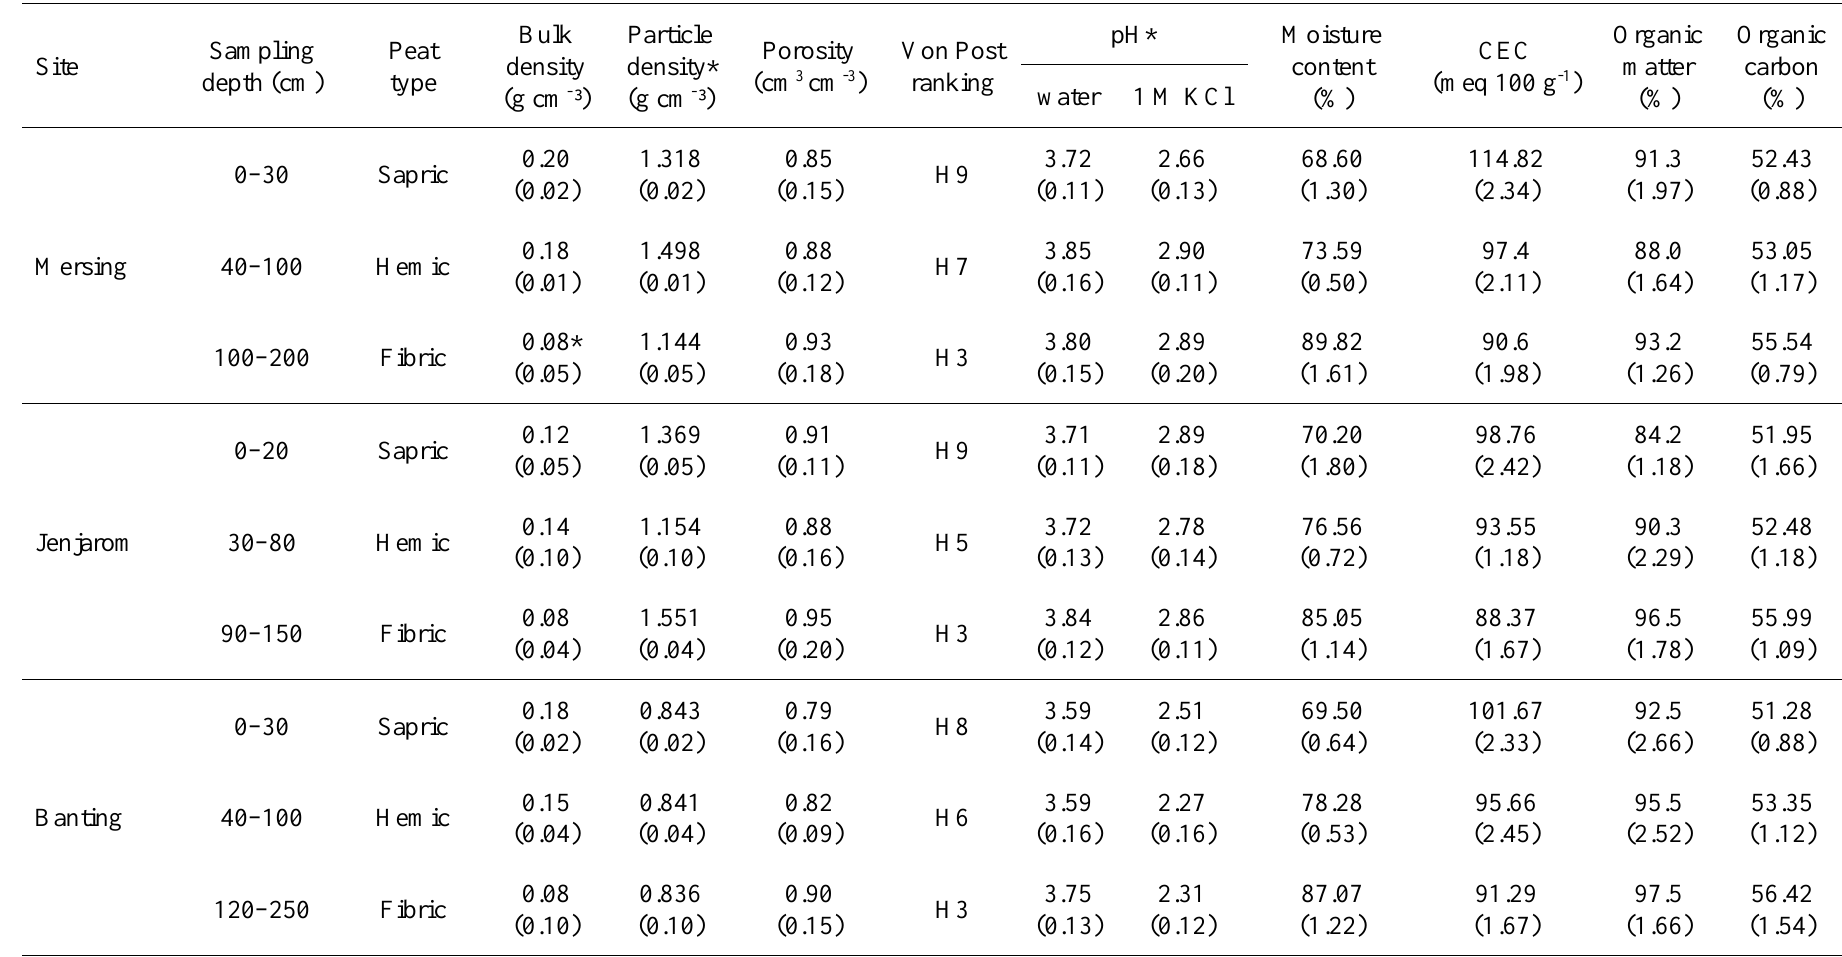
Table 2. Chemical and physical characteristics of the three different peat types (Sapric, Hemic, Fibric) collected from three sites in Peninsular Malaysia (Mersing, Jenjarom, Banting). The values provided are means of three replicate determinations (n=3) except where marked with an asterisk (*) when n=6. In each case, standard deviation (SD) is shown in